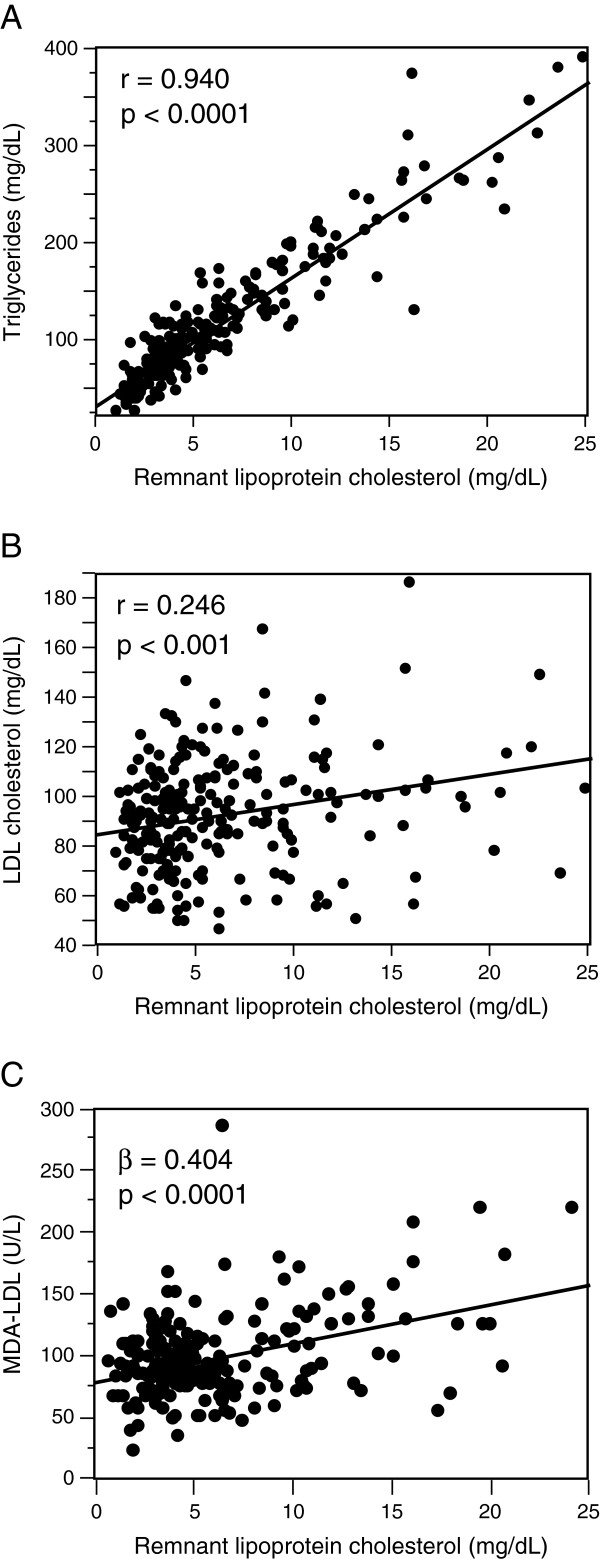
Associations of the remnant lipoprotein cholesterol level with the levels of triglycerides, low-density lipoprotein (LDL) cholesterol, and malondialdehyde-modified LDL (MDA-LDL). A and B, The remnant lipoprotein cholesterol level (mg/dL) was significantly correlated with the levels of triglycerides (mg/dL) (A) and LDL cholesterol (mg/dL) (B) with the indicated correlation coefficient (r) and p value in simple regression analyses. C, The remnant lipoprotein cholesterol level (mg/dL) was significantly correlated with the MDA-LDL level (U/L) with the indicated partial correlation coefficient (β) and p value in a multiple regression model adjusted for LDL cholesterol level.